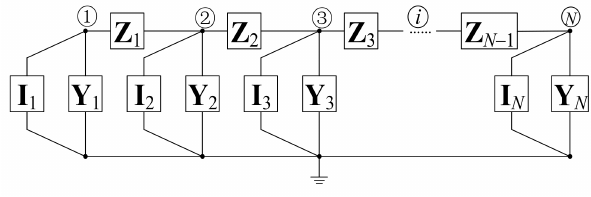
Figure 3. Chain network of the catenary